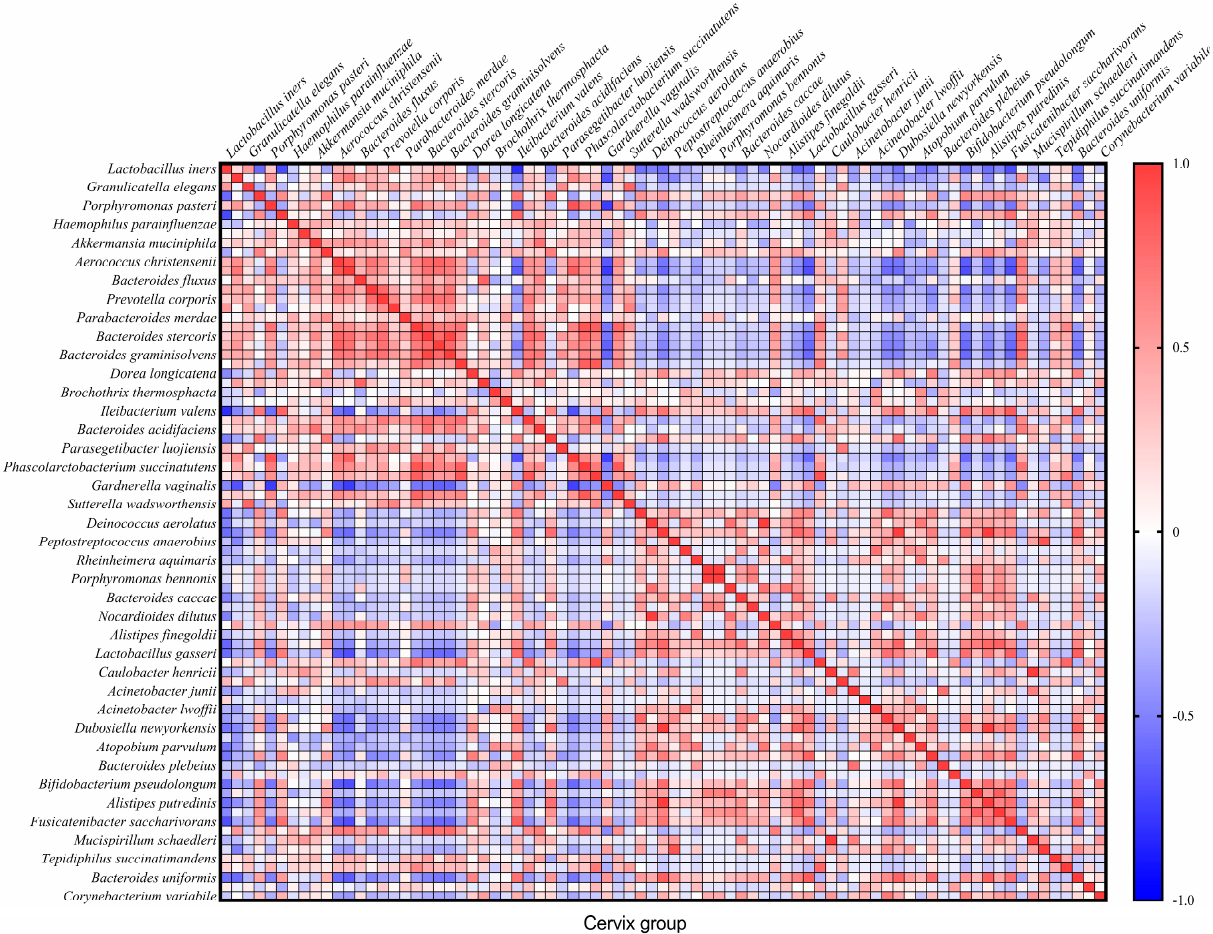
Figure 4. Correlation matrix describing the relationship between microorganisms in the cervical canal group.